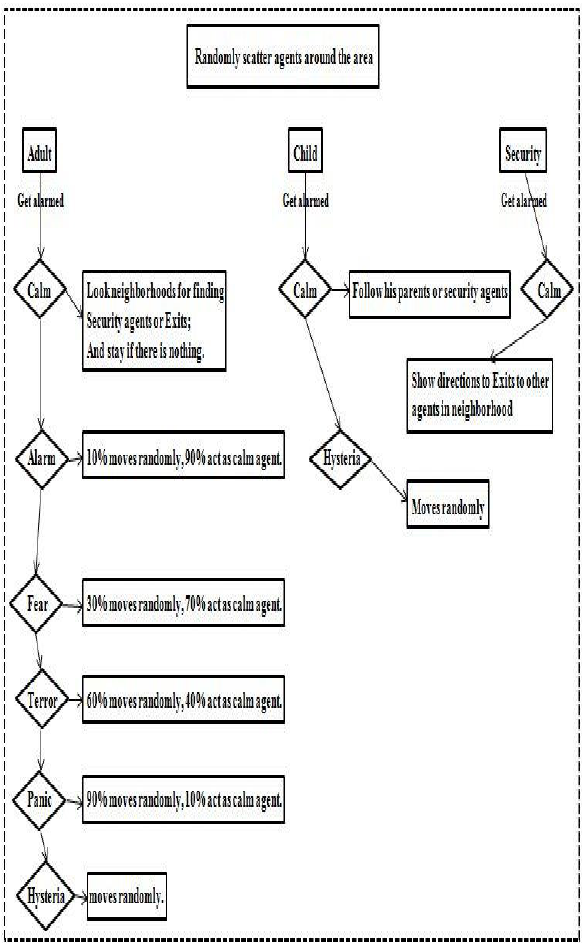
Figure 1. Transition diagrams of agents